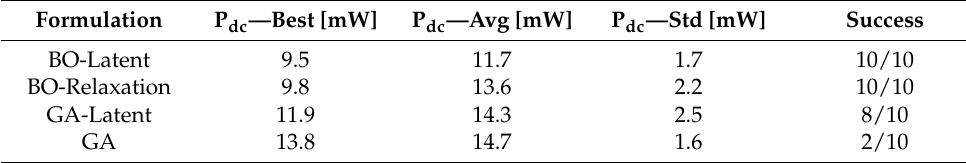
Table 2. LNA sizing results—static power consumption.